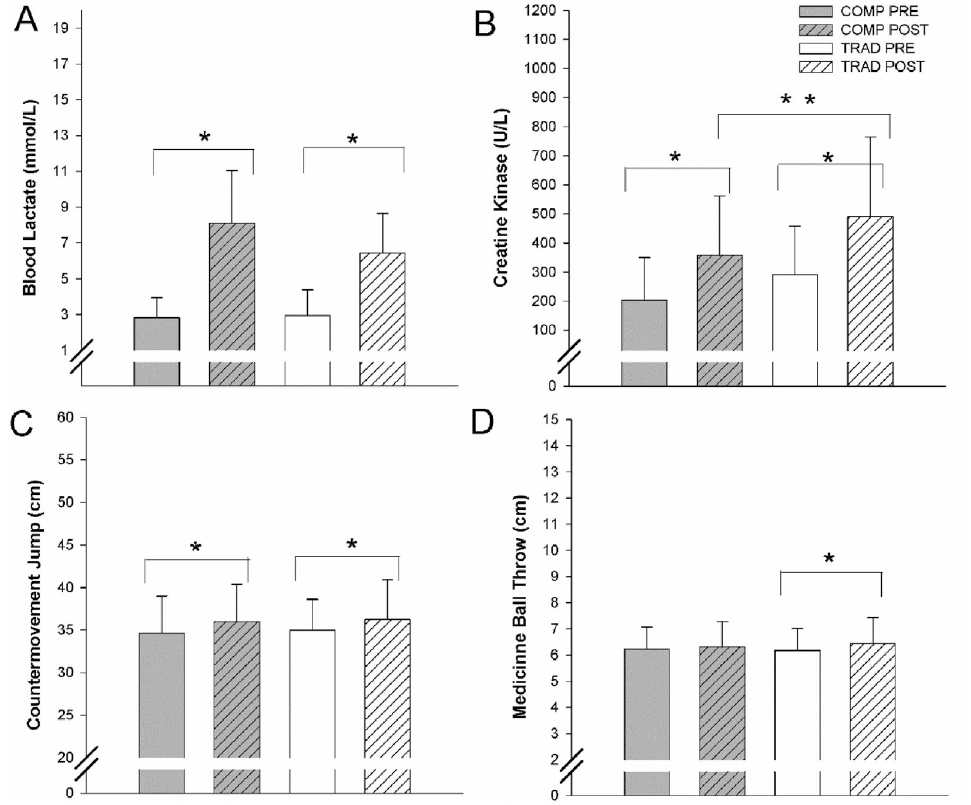
Figure 2 - Physiological and neuromuscular variables. * Time effect ( P < 0.05). ** Group effect ( P